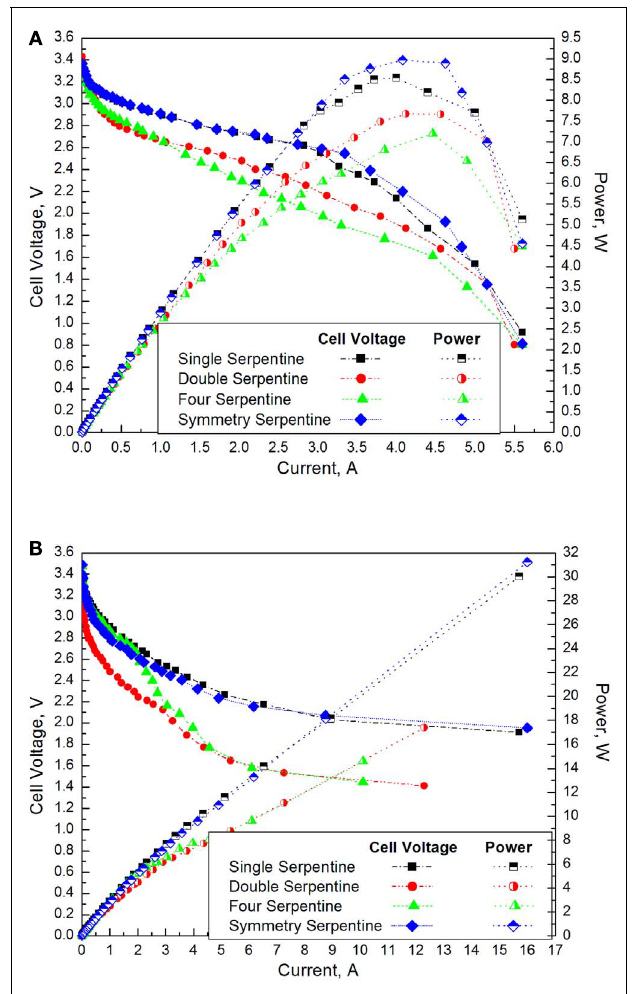
FIGURE 10 | Fuel cell stack voltage and power . (A) Hydrogen flow rate of 200sccm and (B) hydrogen flow rate of